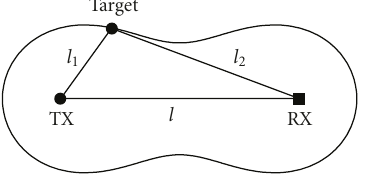
Figure 3: Equi-power positions (Cassini oval) in a bistatic radar.